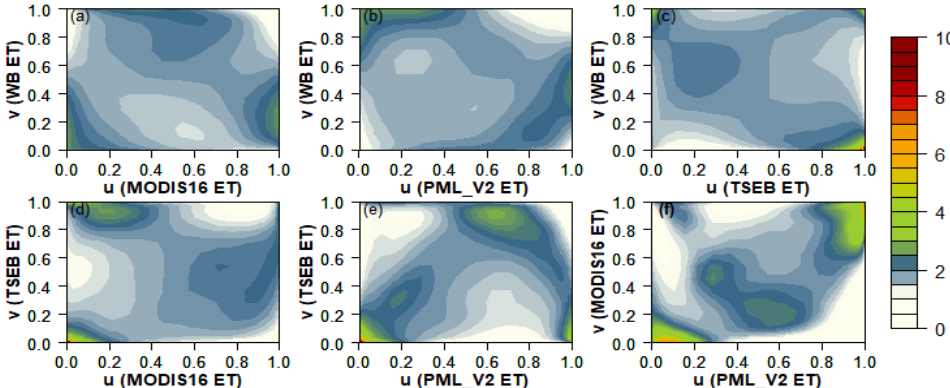
Figure 10. The empirical Copula densities between the satellite RS ET products and surface WB ET estimate. The sample size is 146 (20,654) data tuples in ( a – c ) in ( d – f ) panels for the ET datasets. Panels ( a – c ) indicate the dependence structure pattern of the water balance ET against the three derived remote sensing ET products estimated at catchment-scale (as in Figure 7); while panels ( d – f ) indicate the dependence structures amongst the three remote sensing ET estimated at pixel-by-pixel for the entire domain (as in Figure 3).